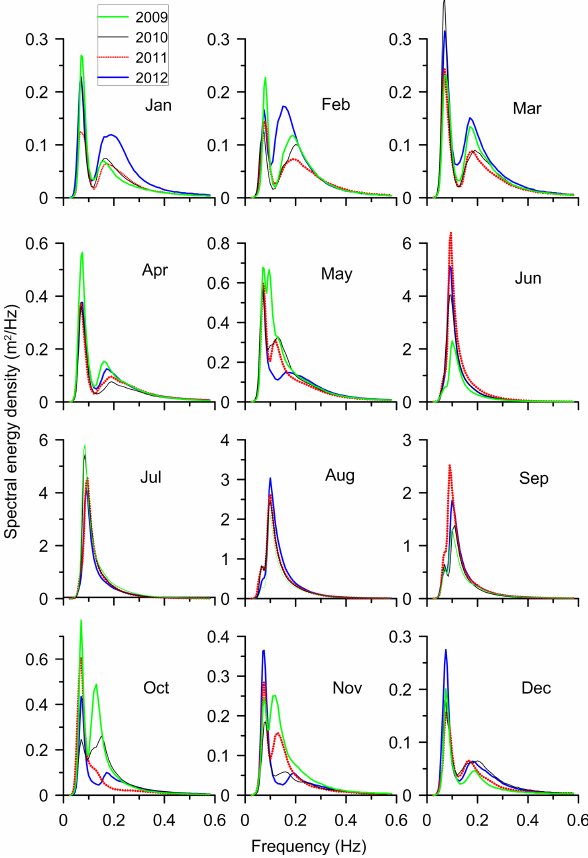
Figure 7. Inter-annual variations in monthly averaged wave spec- trum during